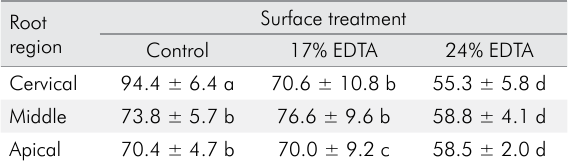
Table 2. Mean values and standard deviation of bond strength (MPa) for self-adhesive resin cement Multilink ® Speed.